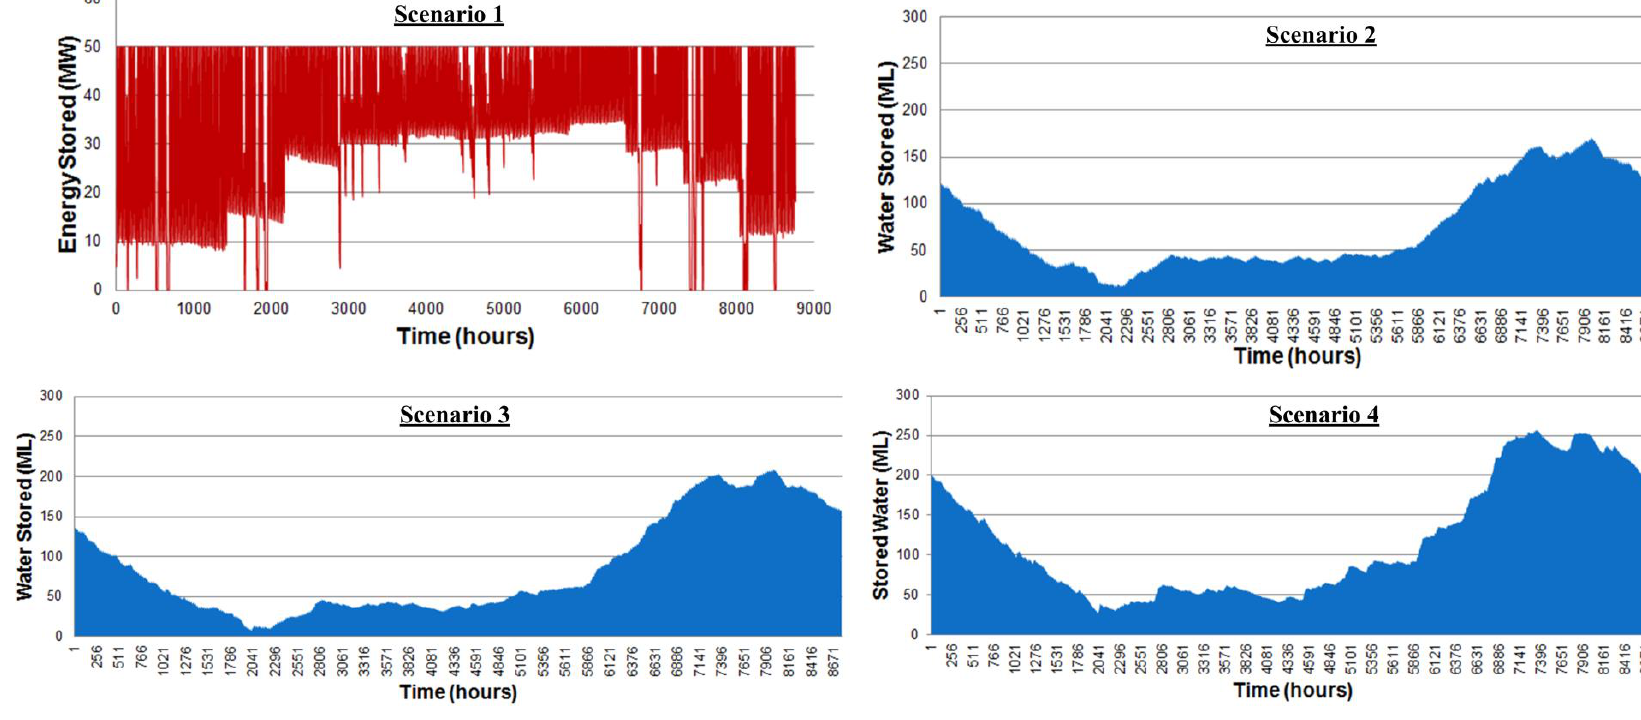
Figure 8. Cumulative storage/Capacities for each scenario.